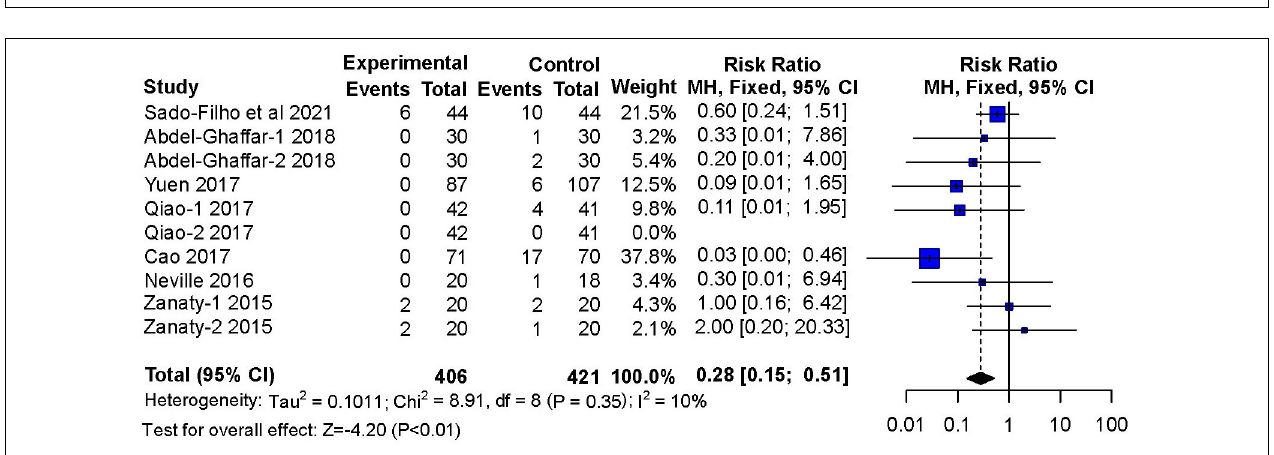
FIGURE 10 | Meta-analysis of nebulized dexmedetomidine for recovery time. CI, confidence interval; df, degress of freedom; M-H, Mantel-Haenszel.